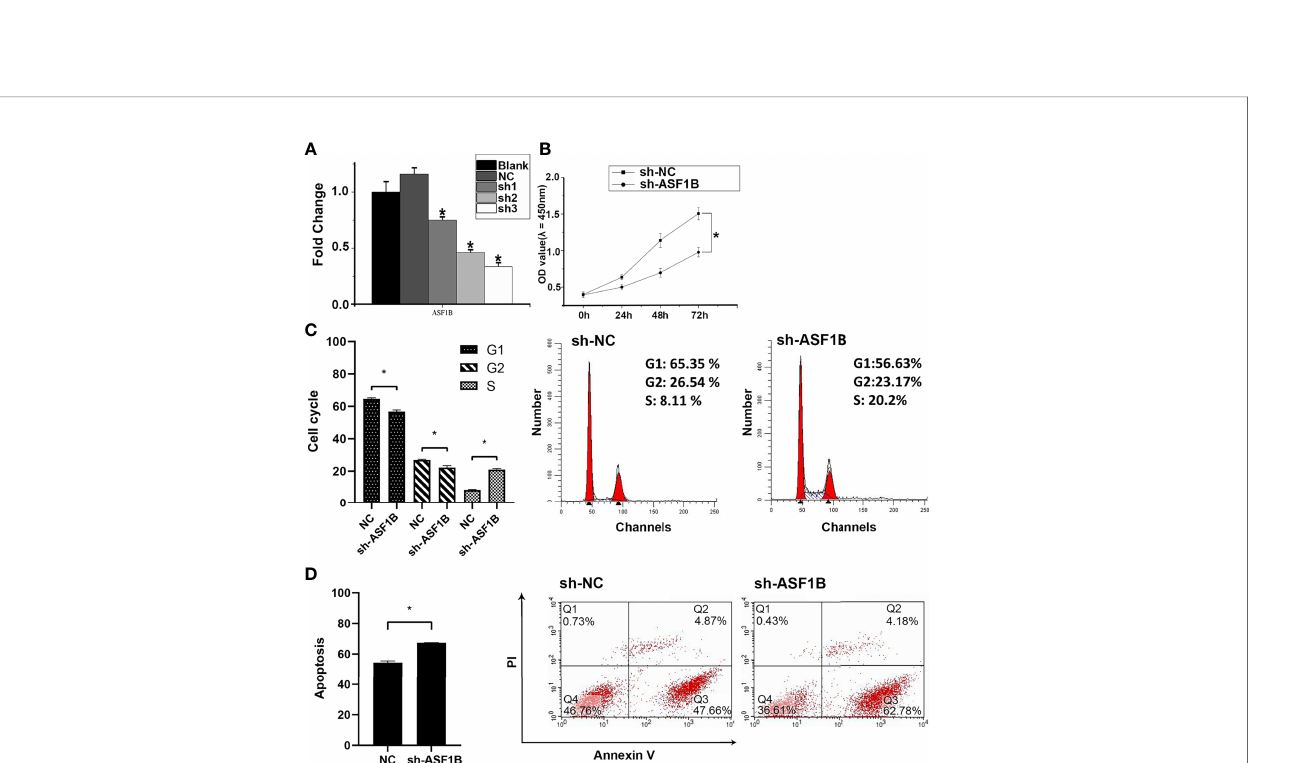
FIGURE 10 | ASF1B could promote proliferation and inhibit apoptosis of male TC cells and accelerate cell cycle. (A) The knockdown ef fi ciency of ASFB1 in KTC-1 cells was measured by real-time PCR. sh-ASF1B-3 (sh3) showed the best silencing effect and was used for the subsequent experiments, *P < 0.05. (B) Cell proliferation were detected by CCK-8 assays in KTC-1 cells, *P < 0.05. Detection of cell cycle (C) and cell apoptosis (D) in KTC-1 cells after transfection with sh-NC or sh-ASF1B by fl ow cytometry, respectively, *P <